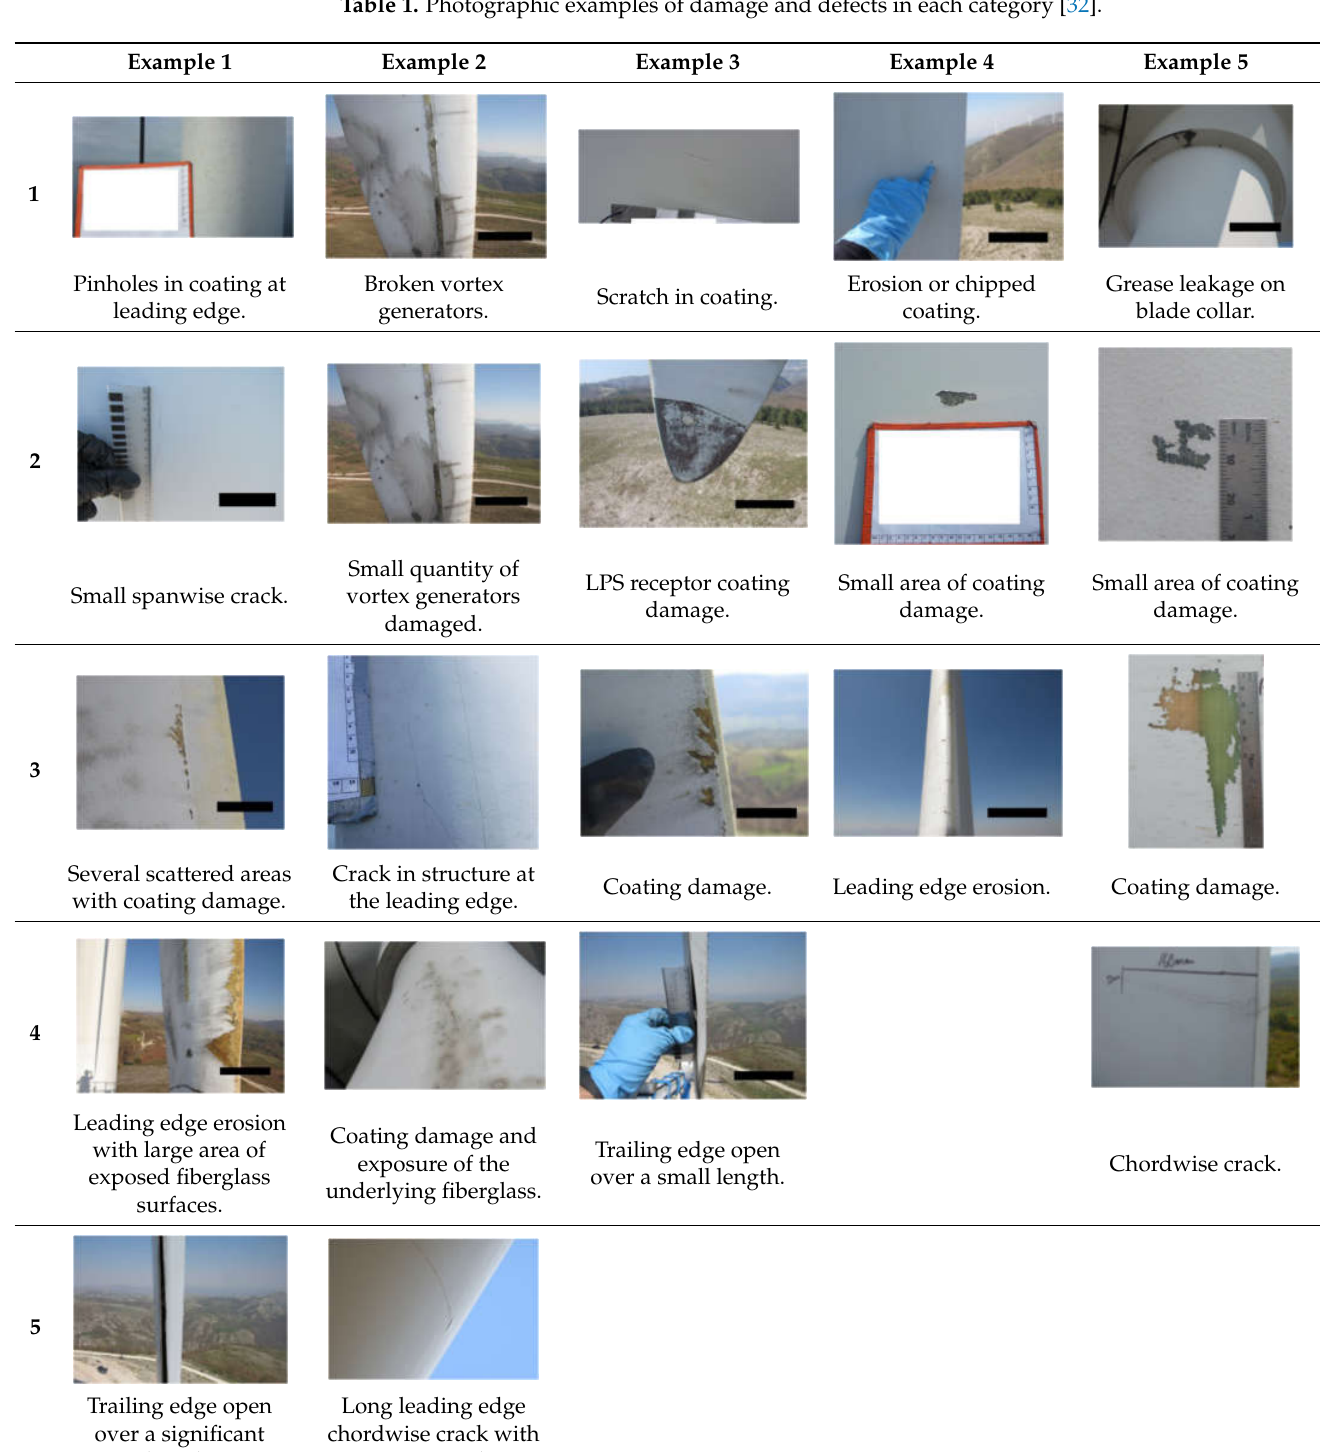
Table 1. Photographic examples of damage and defects in each category [32].